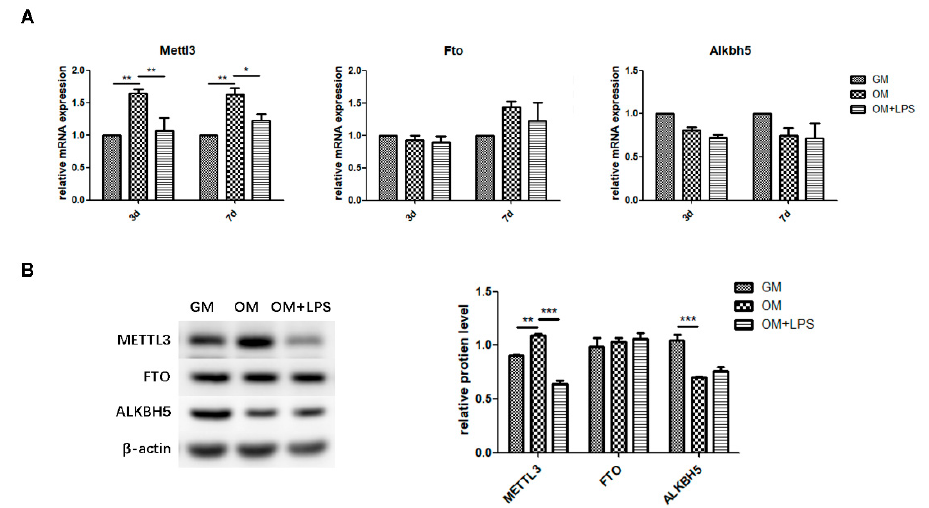
Figure 2. m 6 A methyltransferase and demethylase expression during osteogenesis and inflammation. MC3T3-E1 cells were cultured in osteogenic medium with 1 µ g / mL LPS for 3 days. ( A ) The mRNA expression of Mettl3 , Fto , and Alkbh5 was quantified by qRT-PCR. Gapdh was used as an internal control. ( B ) The protein levels of METTL3, FTO, and ALKBH5 were assessed by western blotting and normalized to that of β -actin. The results are shown as the mean ± SD ( n = 3). * p < 0.05, ** p < 0.01, *** p < 0.001.